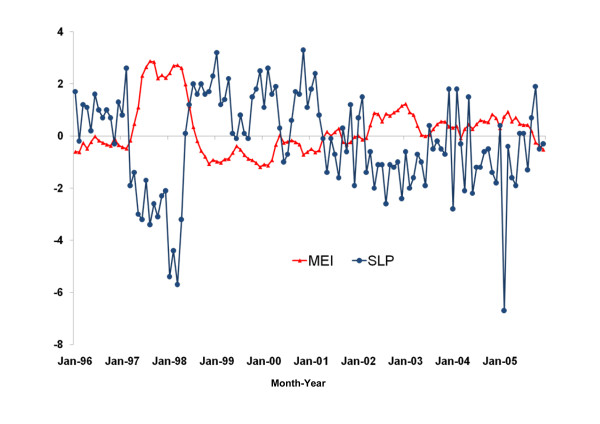
El Niño Southern Oscillation (ENSO) data, 1996-2005. The monthly multivariate ENSO index (MEI) (red line with rectangles) and the anomalies of the sea level pressure index (SLP) (blue line with bars). MEI > 1 (or SLP < -1) defines the occurrence of El Niño. A more positive value of MEI (or a more negative value of SLP) indicates a stronger El Niño.